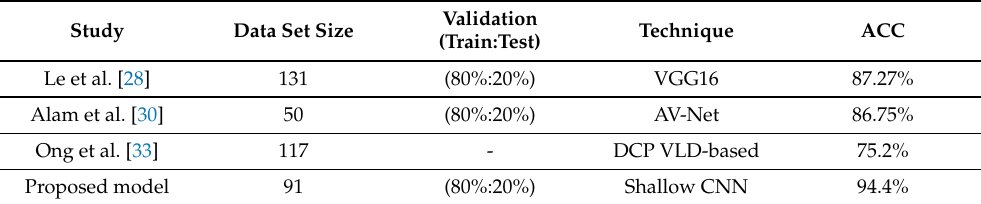
Table 4. Comparisons with the previous works for DR